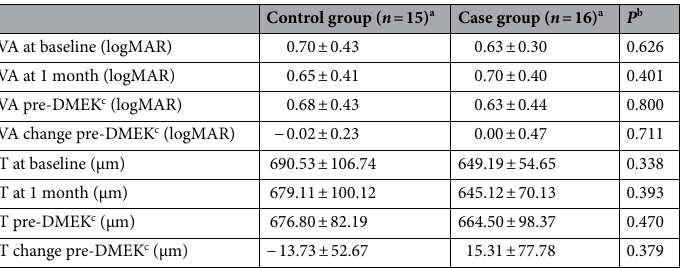
Table 2. BCVA and CCT in the control and case groups. a All values are presented as mean ± SD unless otherwise noted. b Mann-Whitney U test. c CCT and BCVA documented at 6 months if DMEK surgery was deferred. BCVA, best corrected visual acuity; CCT, central corneal thickness; DMEK, Descemet’s membrane endothelial